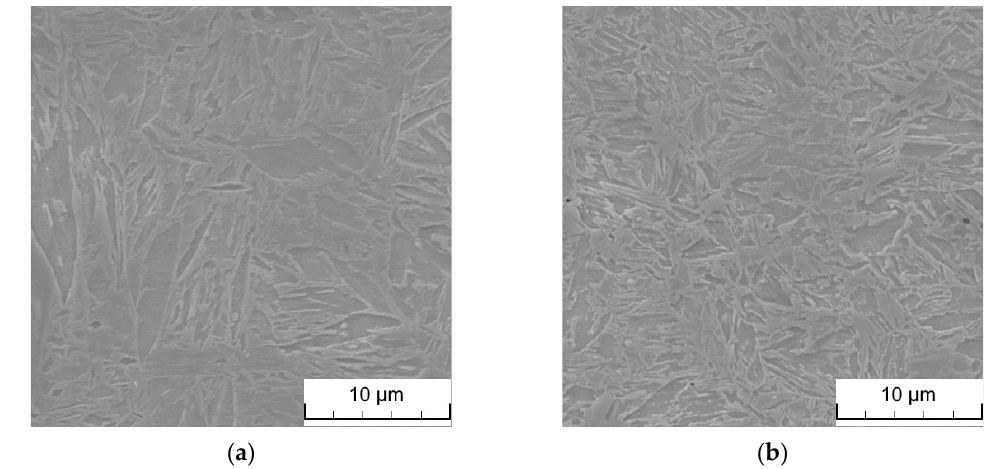
Figure 6. SEM micrographs of coarse ‐ grained martensite ( a ) and fine ‐ grained martensite ( b ) in the UCHAZ.